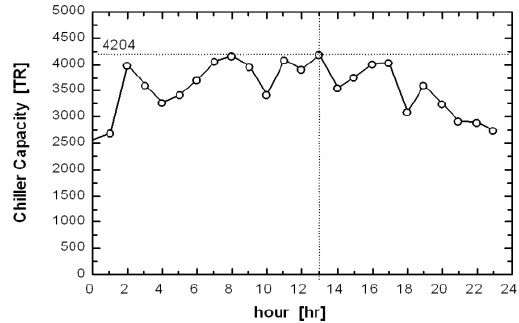
Fig. 6. Chiller capacity with the variation of the climatic conditions (temperature and